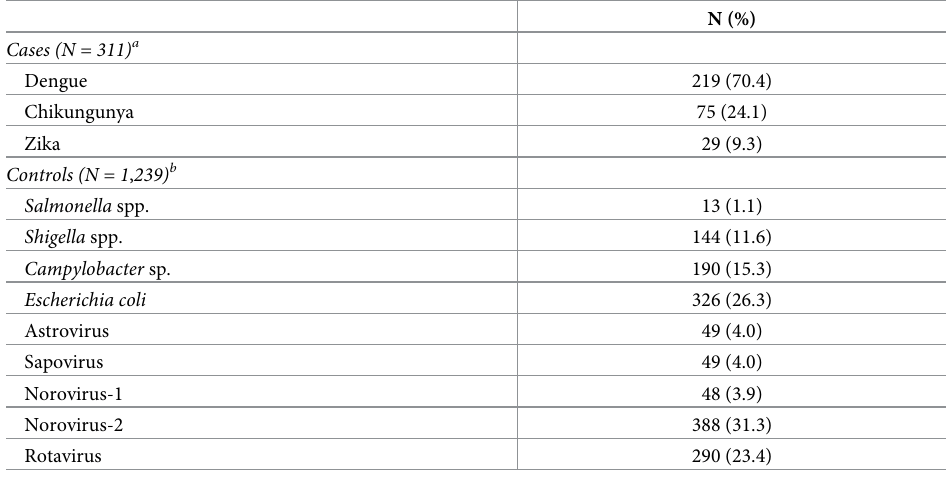
Table 1. Arbovirus frequency among cases; viral and bacterial infections among diarrheal controls, Santa Rosa, Guatemala, 2011–2018.